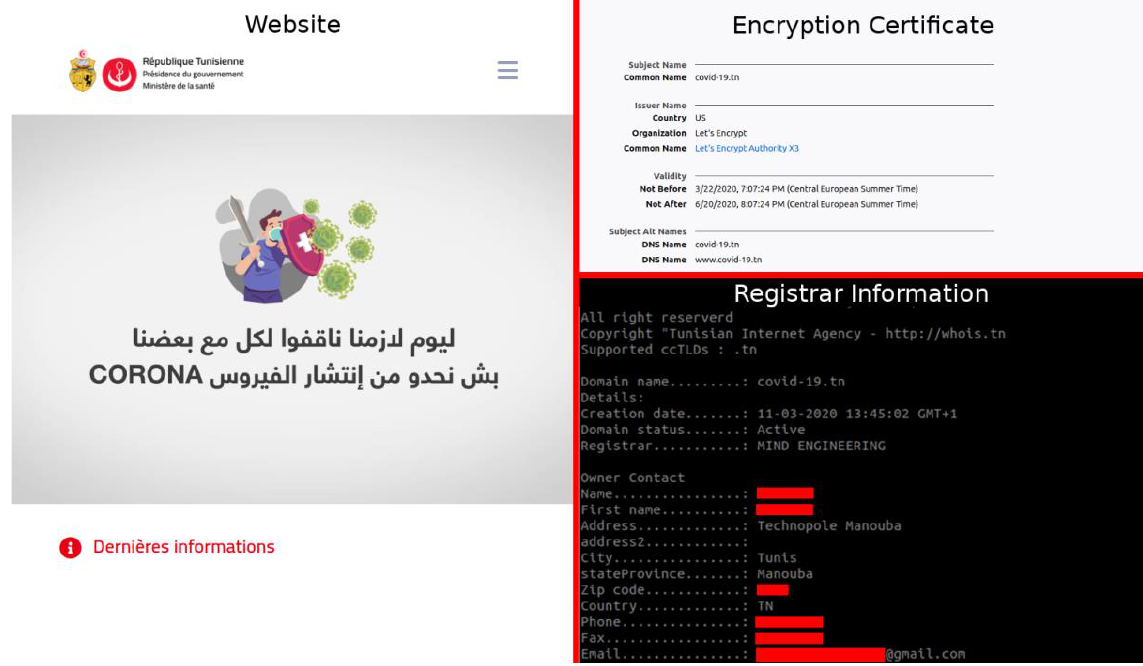
Figure 1. Unverified Tunisian government Covid-19